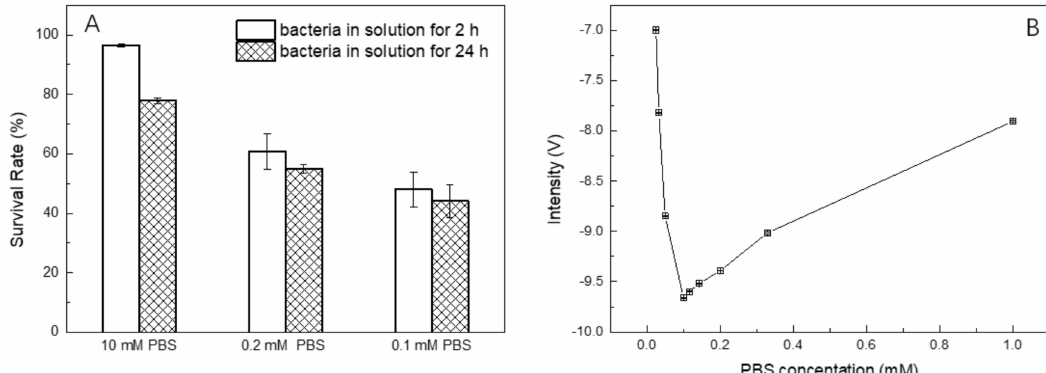
Figure 4. ( A ) Bacteria survival rate in 10 mM PBS solution, 0.2 mM PBS dilution, 0.1 mM PBS dilution and water after 2 h and 24 h were detected by FCM. Bacteria were dyed by PI for 10 min. Error bars are standard deviations of 3 measurements. ( B ) The relationship between PBS dilution and C4D intensity. Error bars are standard deviations of 4